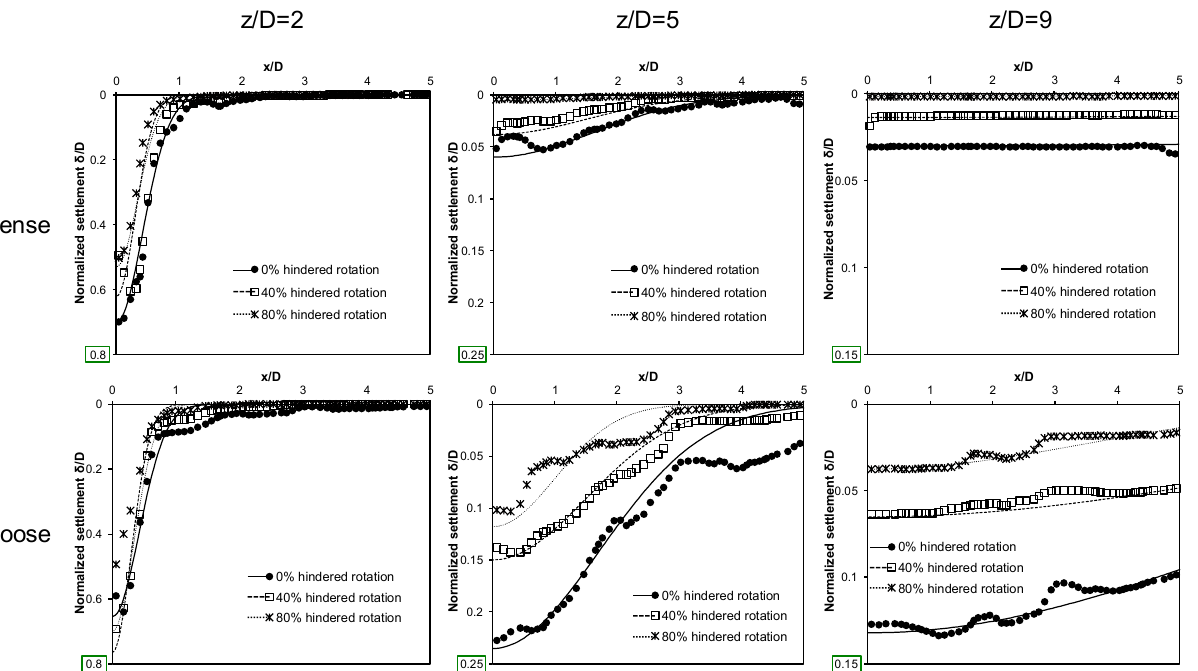
Figure 5. Surface settlement after dissolution. The data—folded at the centerline—are fitted with a Gaussian function. Note the ranges in y-axes are not the same for different z/D as indicated by the green square frames.